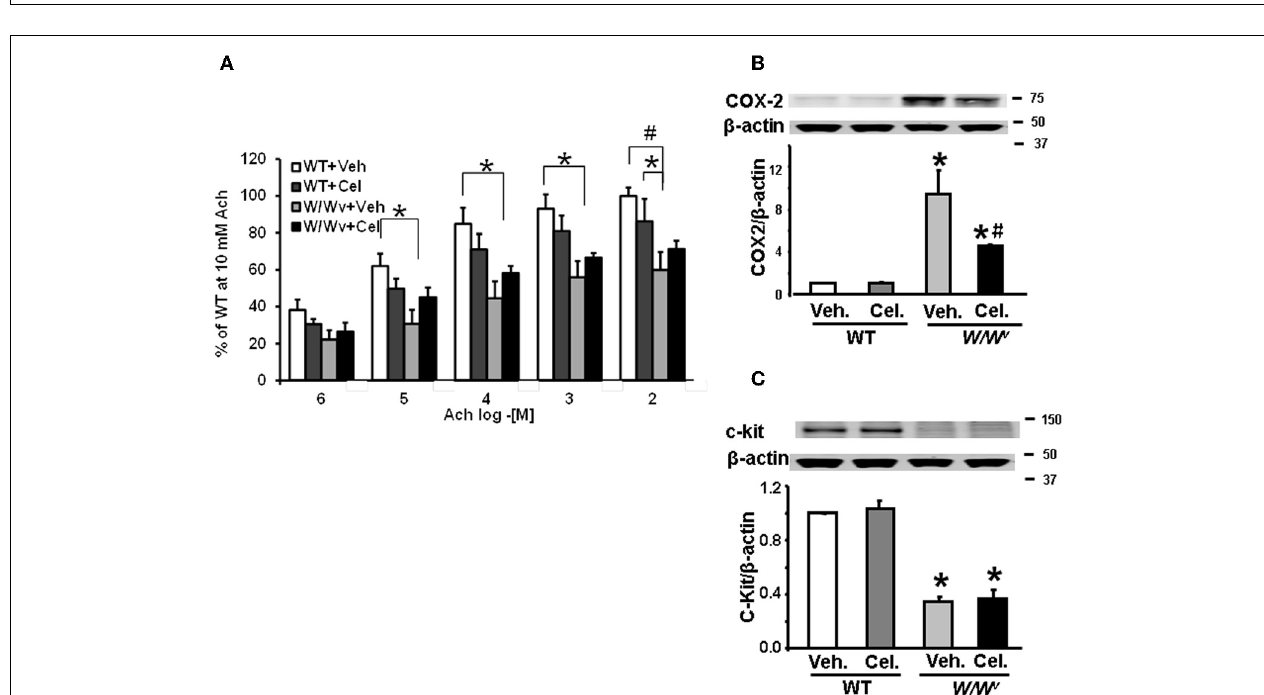
FIGURE 3 | Expression of inflammatory mediators in fundus muscularis externa from wild type, W/W v , and W/W v + mast cell reconstituted mice. (A) Bar graph showing no significant difference in MPO activity between the three types of mice. (B) Western blot showing a significant increase in COX-2 expression